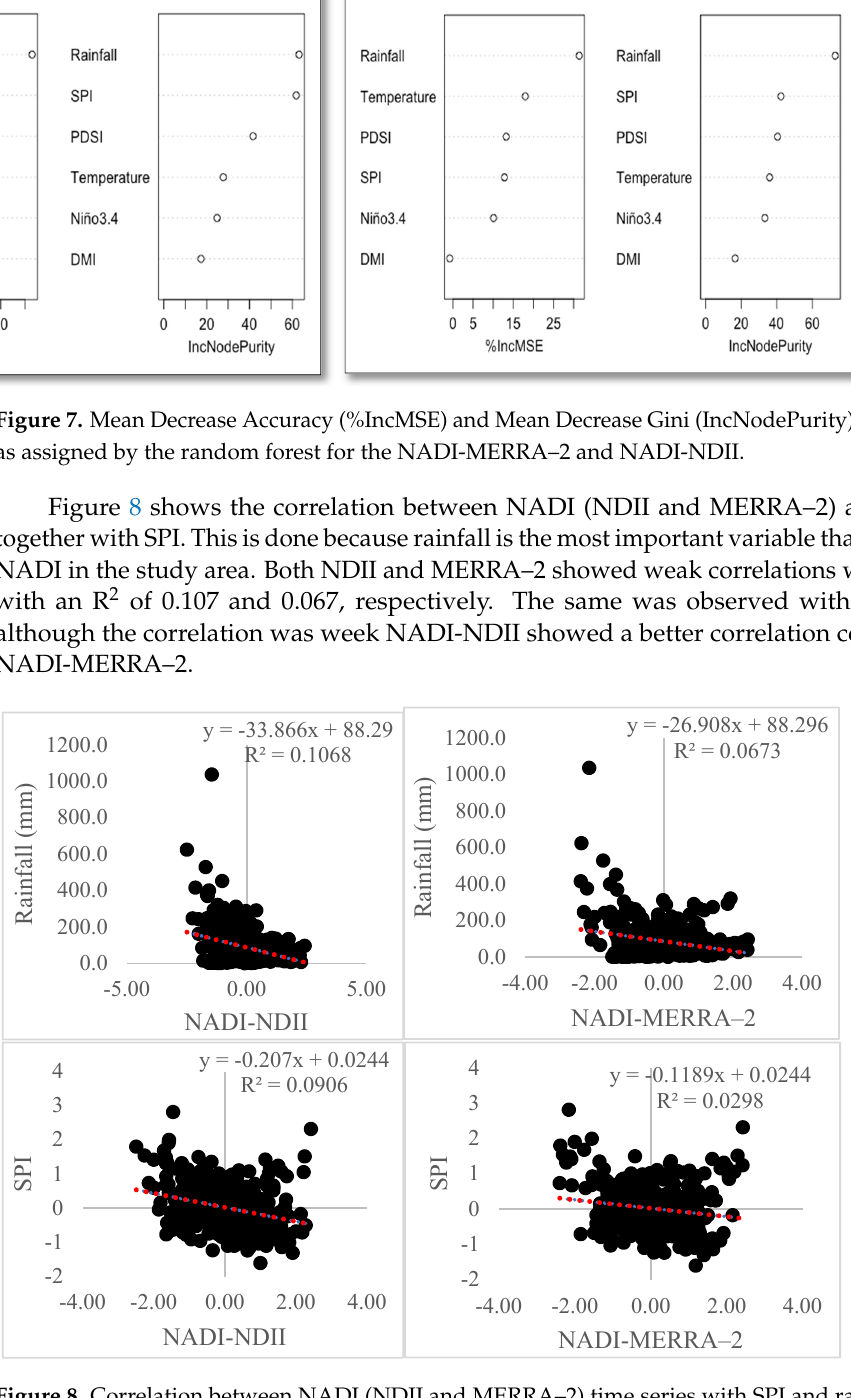
Figure 8. Correlation between NADI (NDII and MERRA–2) time series with SPI and rainfall.